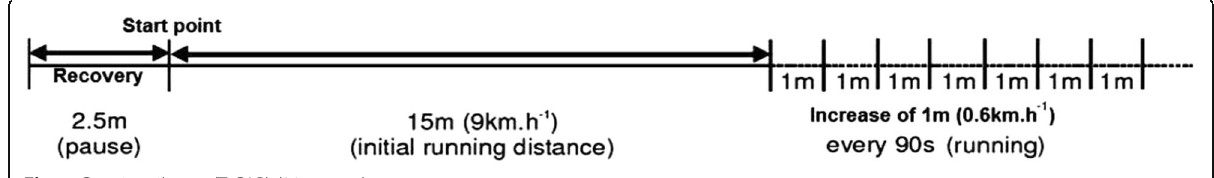
Fig. 4 Carminatti ’ s test (T-CAR) (30 × 15